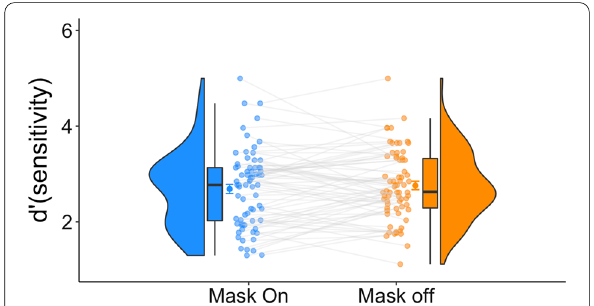
Fig. 5 Experiment 4 results. Similar accuracy results were observed for the two masking conditions (mask off and mask on the forehead). For each condition we present the distribution, the individual datapoints, and the quartiles of the dataset. The whiskers depict the rest of the distribution excluding outliers. The darker dots denote the means, and the error bars denote one standard